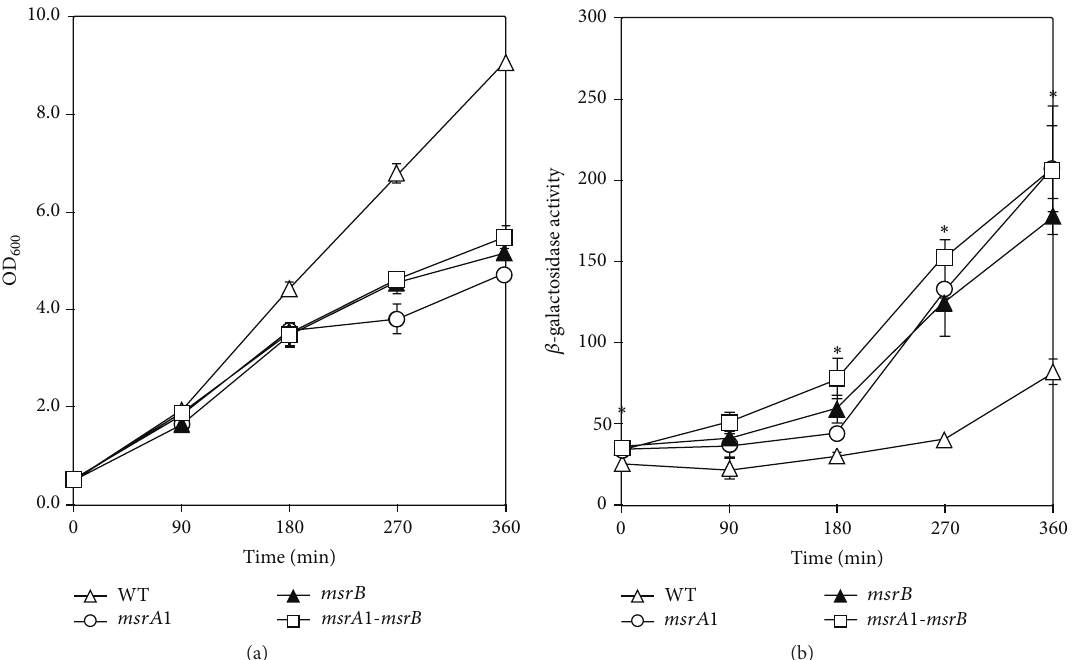
Figure 1: Regulation of msrA1/msrB locus in a methicillin-sensitive S. aureus strain SH1000. The msrA1/msrB promoter- lacZ reporter strains were cultured in TSB and growth was measured as OD 600 (a). 𝛽 -galactosidase activity levels were measured in wild-type S. aureus strain SH1000 (open triangles) and its derivatives msrA1 (open circles), msrB (closed triangles), and msrA1-msrB (open square) mutants during different stages of growth (b). Values indicate averages of data from at least three independent experiments ± standard error (SE) ( ∗ significant at 𝑝 ≤ 0.05 ).